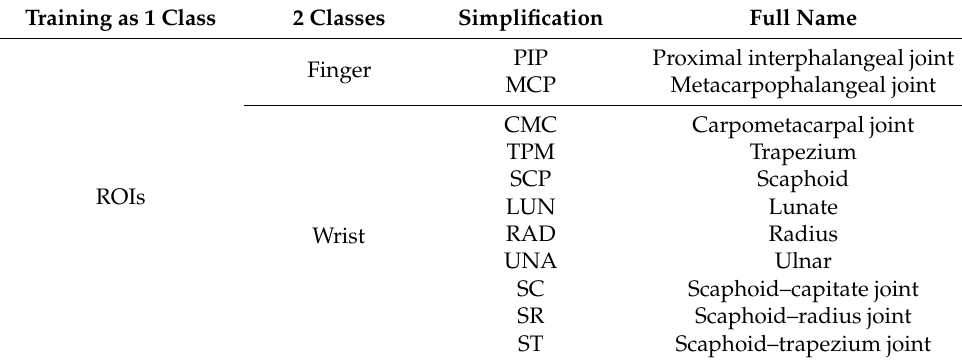
Table 1. the abbreviations of the